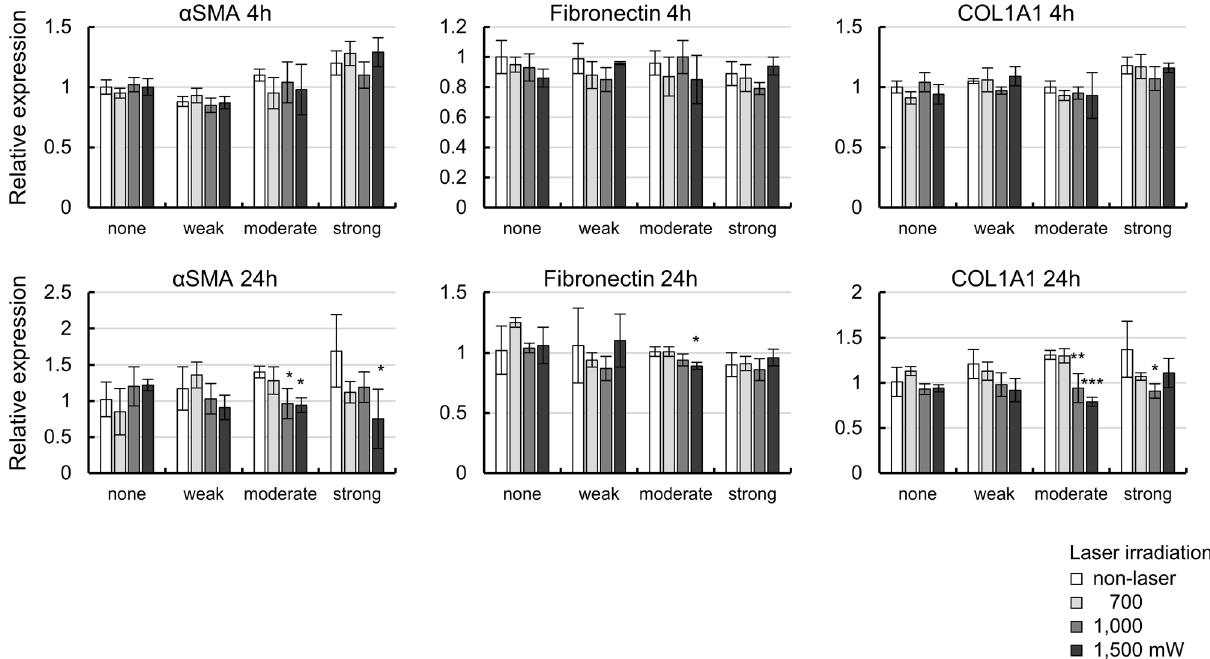
Figure 6. Expression levels of extracellular matrixes after 4 or 24 h of MP-laser irradiation of cells with each pigmentation intensity. mRNA levels of ECMs were measured by qPCR (n = 3). Data are represented as mean ± standard deviation of the mean (n = 3). * P < 0.05, ** P < 0.01, *** P < 0.001 by Dunnet’s multiple comparisons